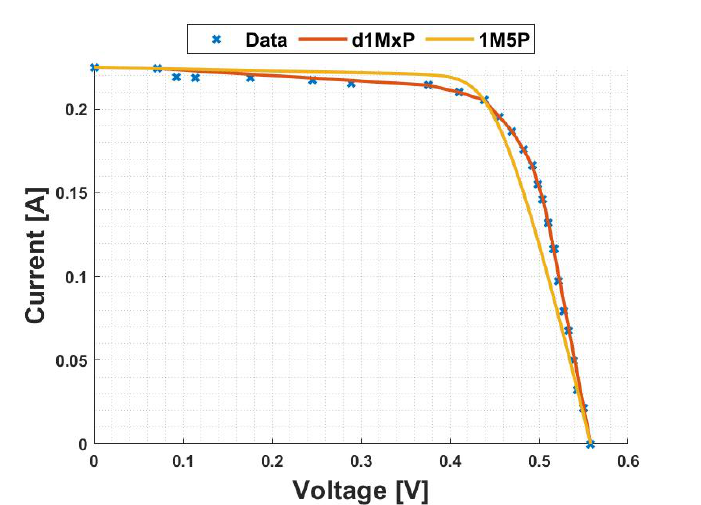
Figure 6. I-V curves using the 1M5P model and the proposed model, at T = 25 ◦ C. Table 1. Quantitative values computed for the branches connected in parallel, for T = 25 ◦